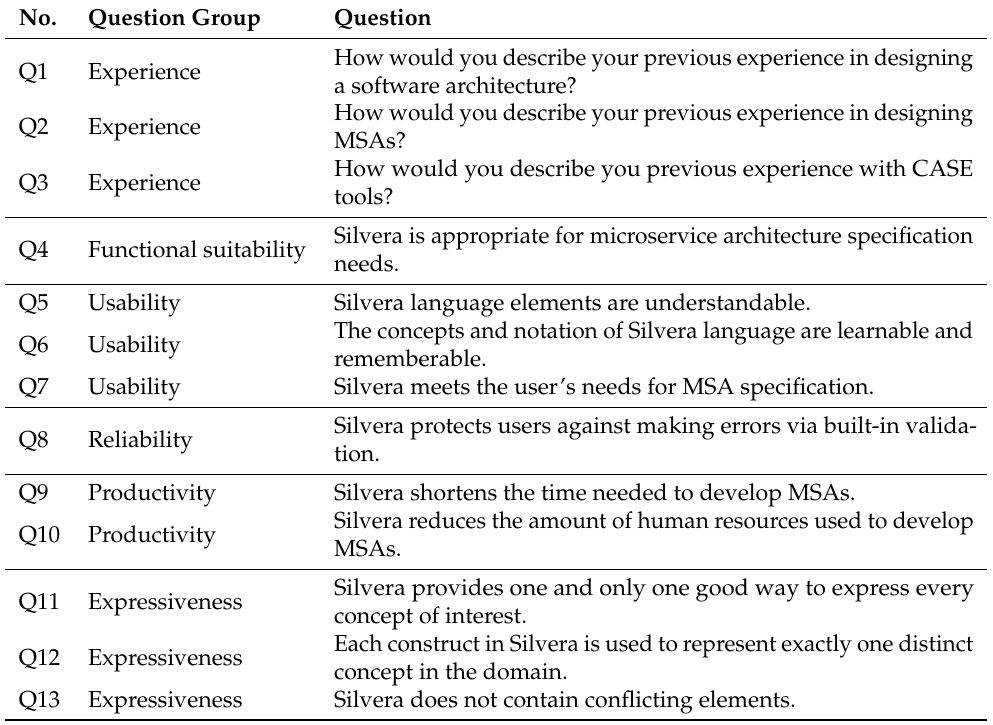
Table 13. The survey questions. All questions were closed type, and only one answer could be